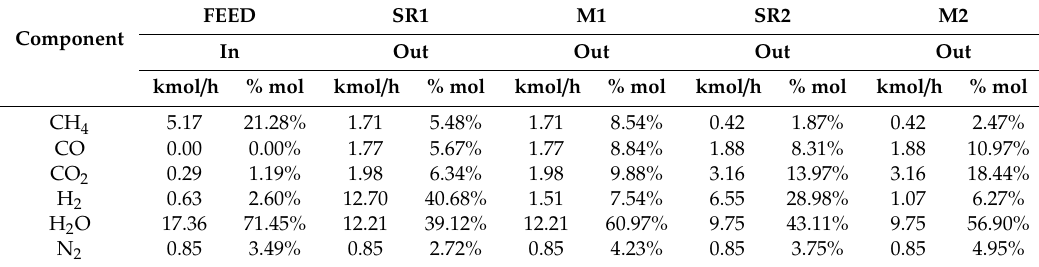
Table 4. Gas composition for